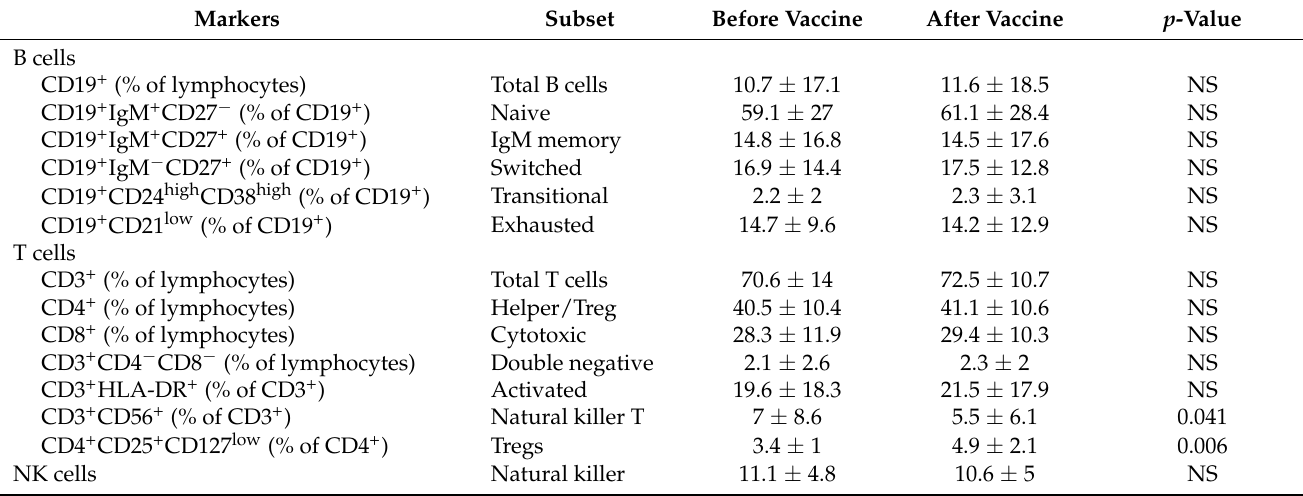
Table 1. Changes of lymphocyte subpopulations after two doses of BNT162b2 vaccine in patients with CryoVas. Data are expressed as mean ± SD; NS, not statistically